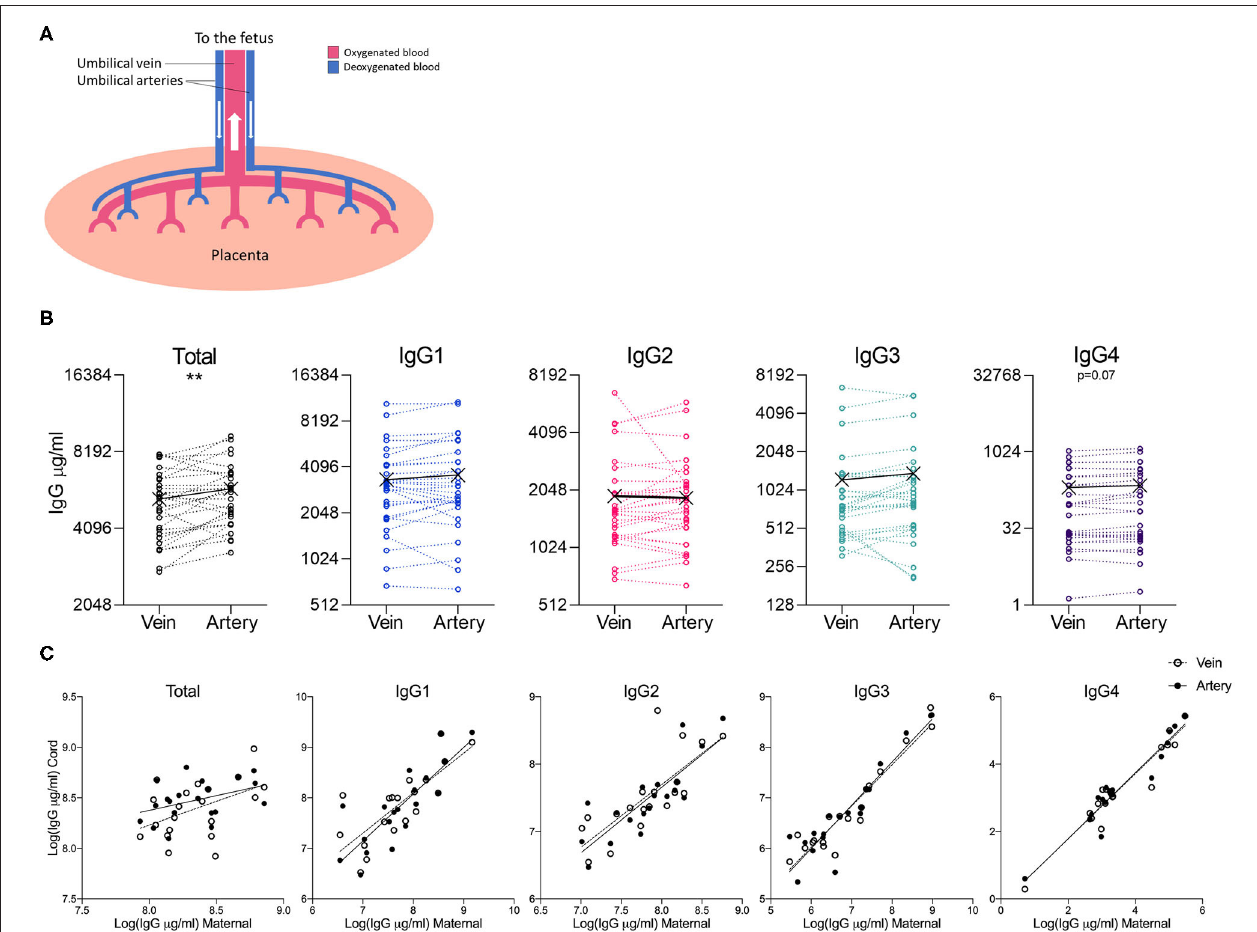
FIGURE 4 | Comparison of IgG subclasses in umbilical cord vein and arterial blood. (A) Illustration of the placental circulation, showing the umbilical arteries bringing deoxygenated blood from the placenta to the fetus, and oxygenated blood returning to the fetus from the placenta via the umbilical vein. (B) Dot-line plots showing the relationship between IgG concentrations in paired umbilical cord vein and artery serum samples ( n = 30). Groups compared by paired t- test on nLog-transformed data. ** p < 0.01 (C) Correlations between maternal and cord IgG concentrations. Lines indicate simple linear regression. nLog values analyzed by Pearson r- test. N = 30 matched umbilical vein/umbilical artery serum pairs and 20 matched maternal/umbilical vein/umbilical artery serum